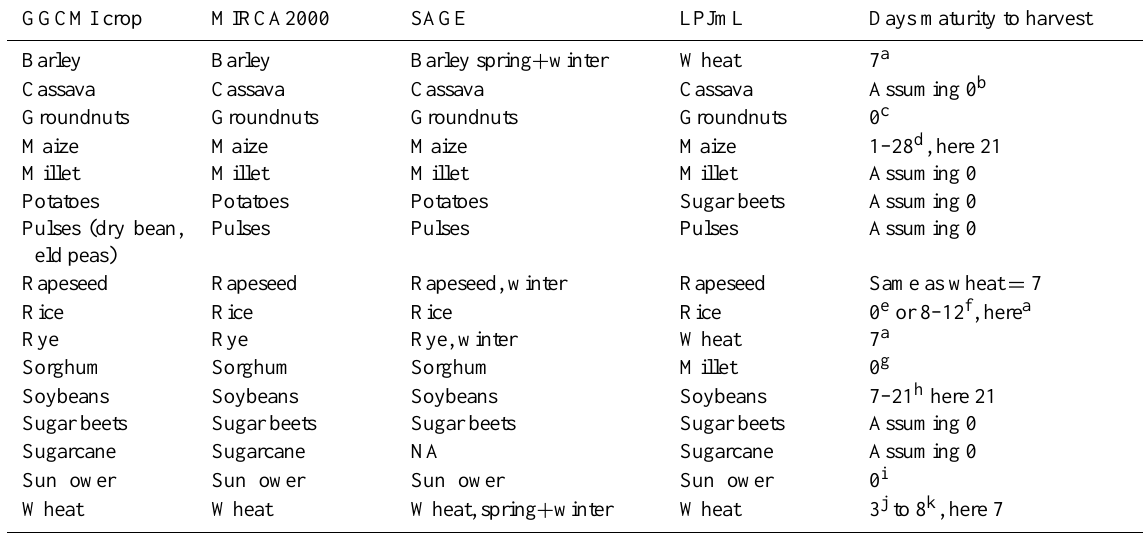
Table 11. Combination of crop calendar data in GGCMI data sets.